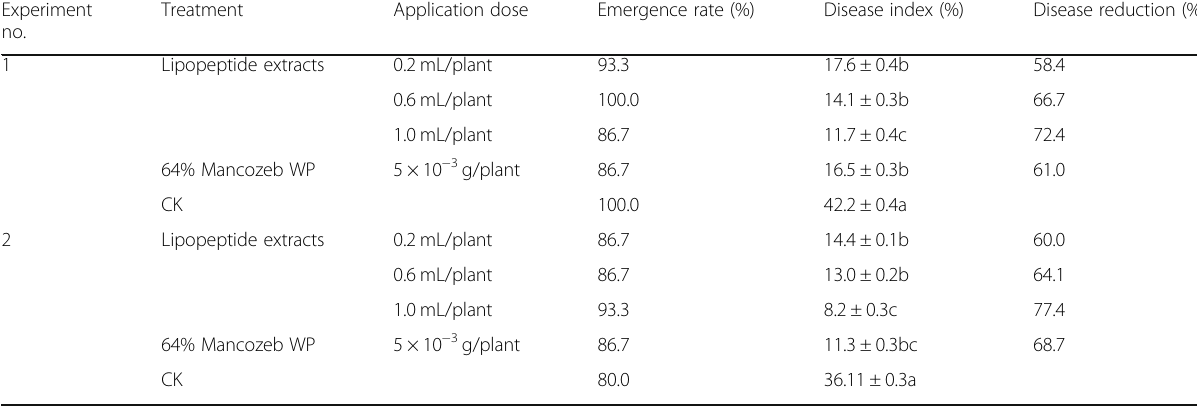
Table 4 Lipopeptide extracts of BM21 for the control of Fusarium graminearum Experiment